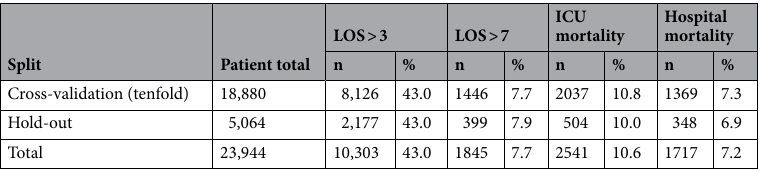
Table 1. Inner-task event frequency is consistent between cross-validation and hold-out validation cohorts for all four binary classification outcomes (0.05–0.84%). Intra-task event frequency provides diversity between binary classification outcomes (7.17–43.03%). LOS, length of stay.